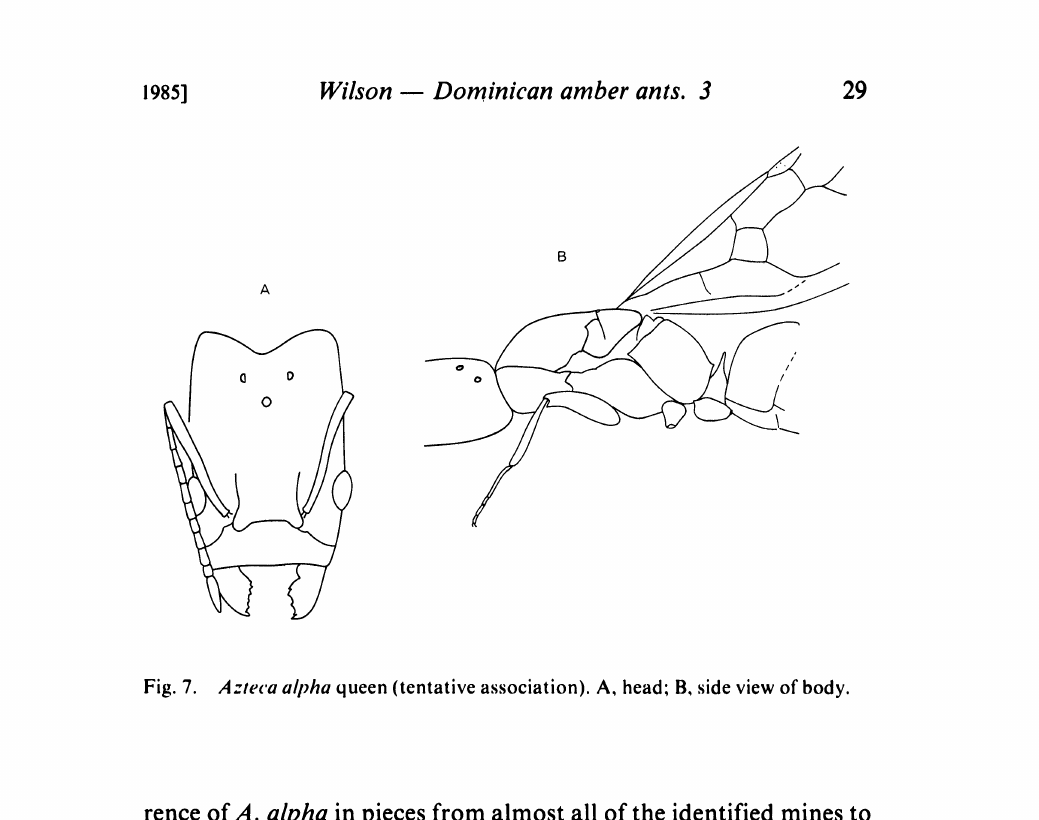
Fig. 7. Azteca alpha queen (tentative association). A, head; B, side view of